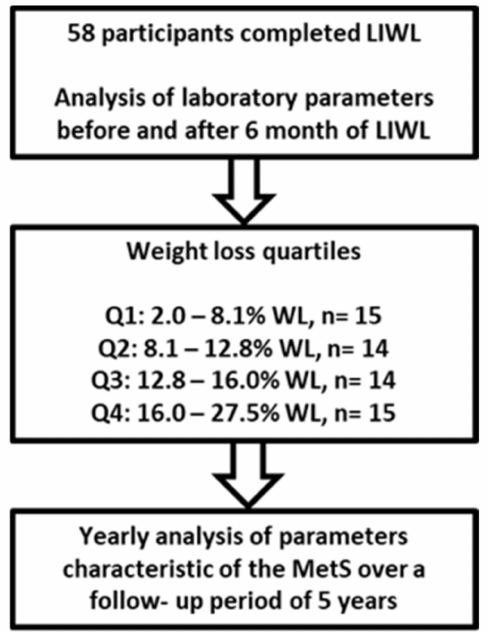
Figure 1. Schematic of study design. The study was embedded in a controlled, monocentric, 6-month lifestyle-induced weight loss (LIWL) trial. Paired blood samples were collected before and after LIWL as well as after each year of follow-up (total: 5 years of follow-up). For statistical analysis, participants were divided into four quartiles based on the extent of weight loss. Fifty-eight participants completed the LIWL program and were included in the data